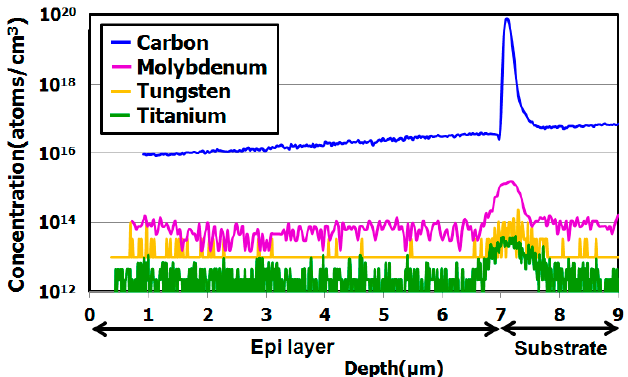
Figure 6. SIMS depth profile of hydrocarbon–molecular–ion–implanted epitaxial silicon wafers after metallic impurity diffusion heat treatment [29]. The epitaxial thickness is 7 μ m and hydrocarbon dose amount is 1 × 10 15 cm − 2 . Modified from Kurita et al. [29], Copyright (2016) The Japan Society of Applied Physics.